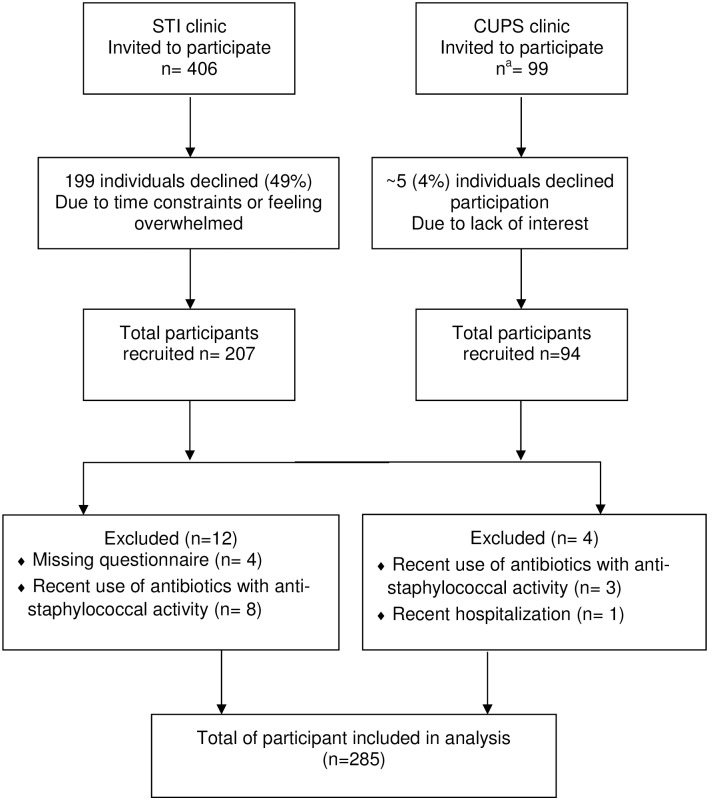
Flow diagram of study participants.aEstimated number.